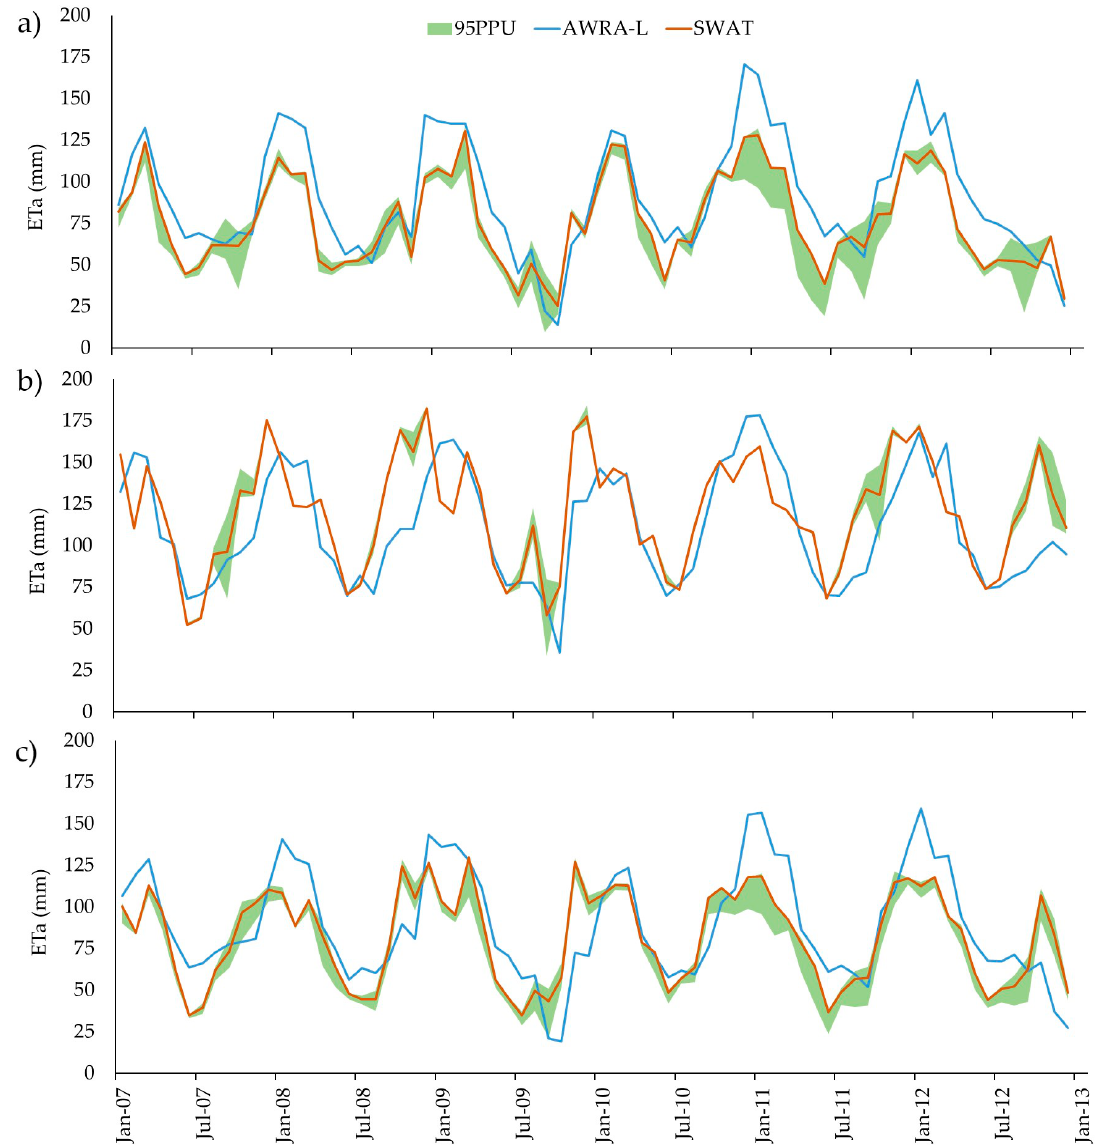
Figure 9. Monthly ET a simulated by SWAT and AWRA-L. ( a ) is the pasture dominated area, ( b ) is the rainforest dominated area and ( c ) is the mixed pasture and rainforest area.